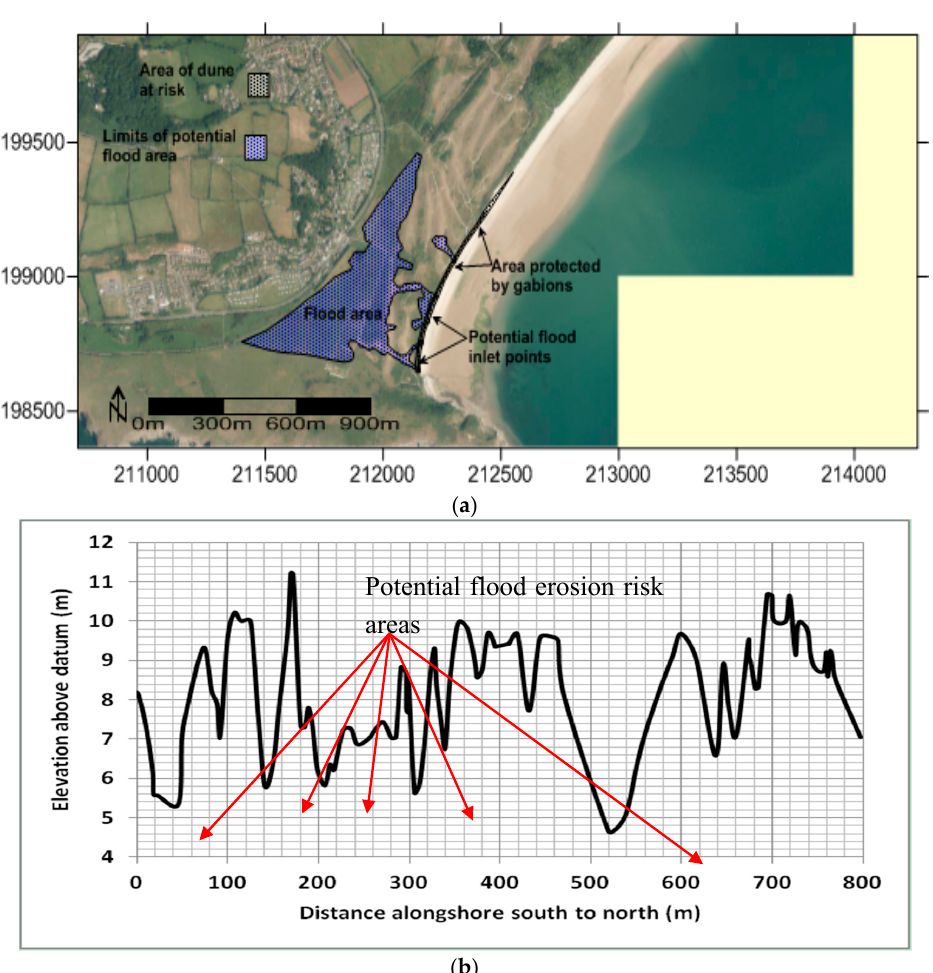
Figure 12. ( a ) 2014 Aerial photograph illustrating flood limits based upon the estimated shoreline position and ( b ) a graphical representation of the existing ground profile along the predicted shoreline position.